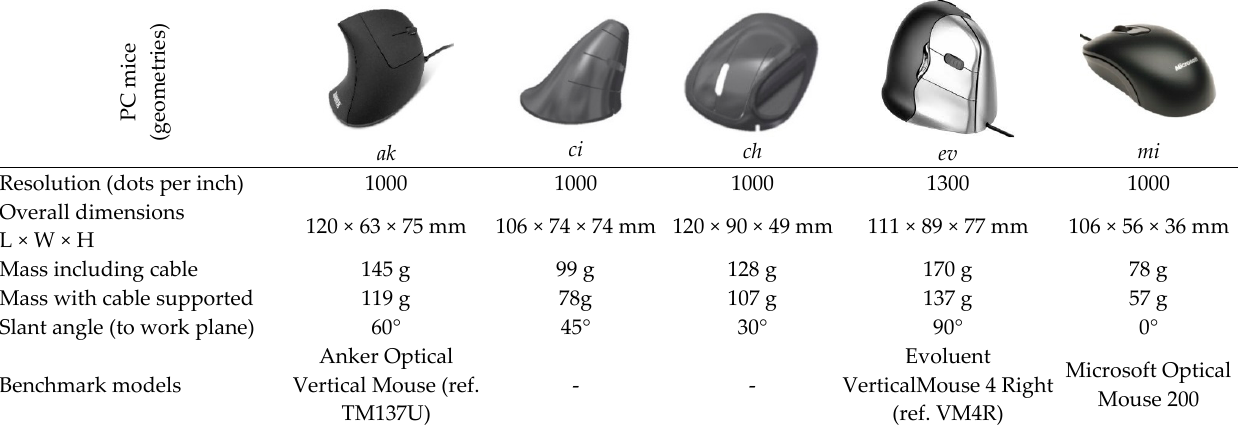
Figure 9. PC mice used in comparative evaluation through graphical tasks (ci and ch are the developed geometries).